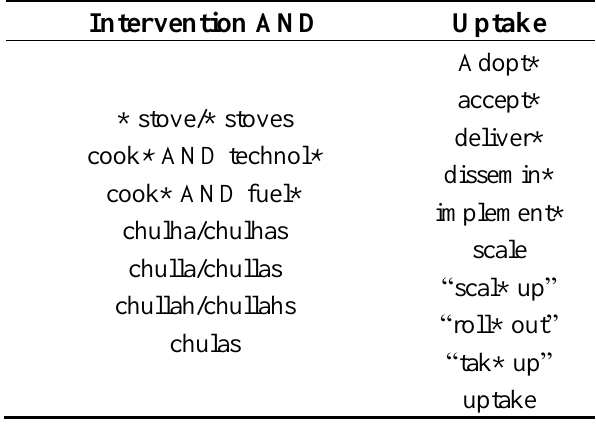
Table 1. Search terms used for the main search strategy on